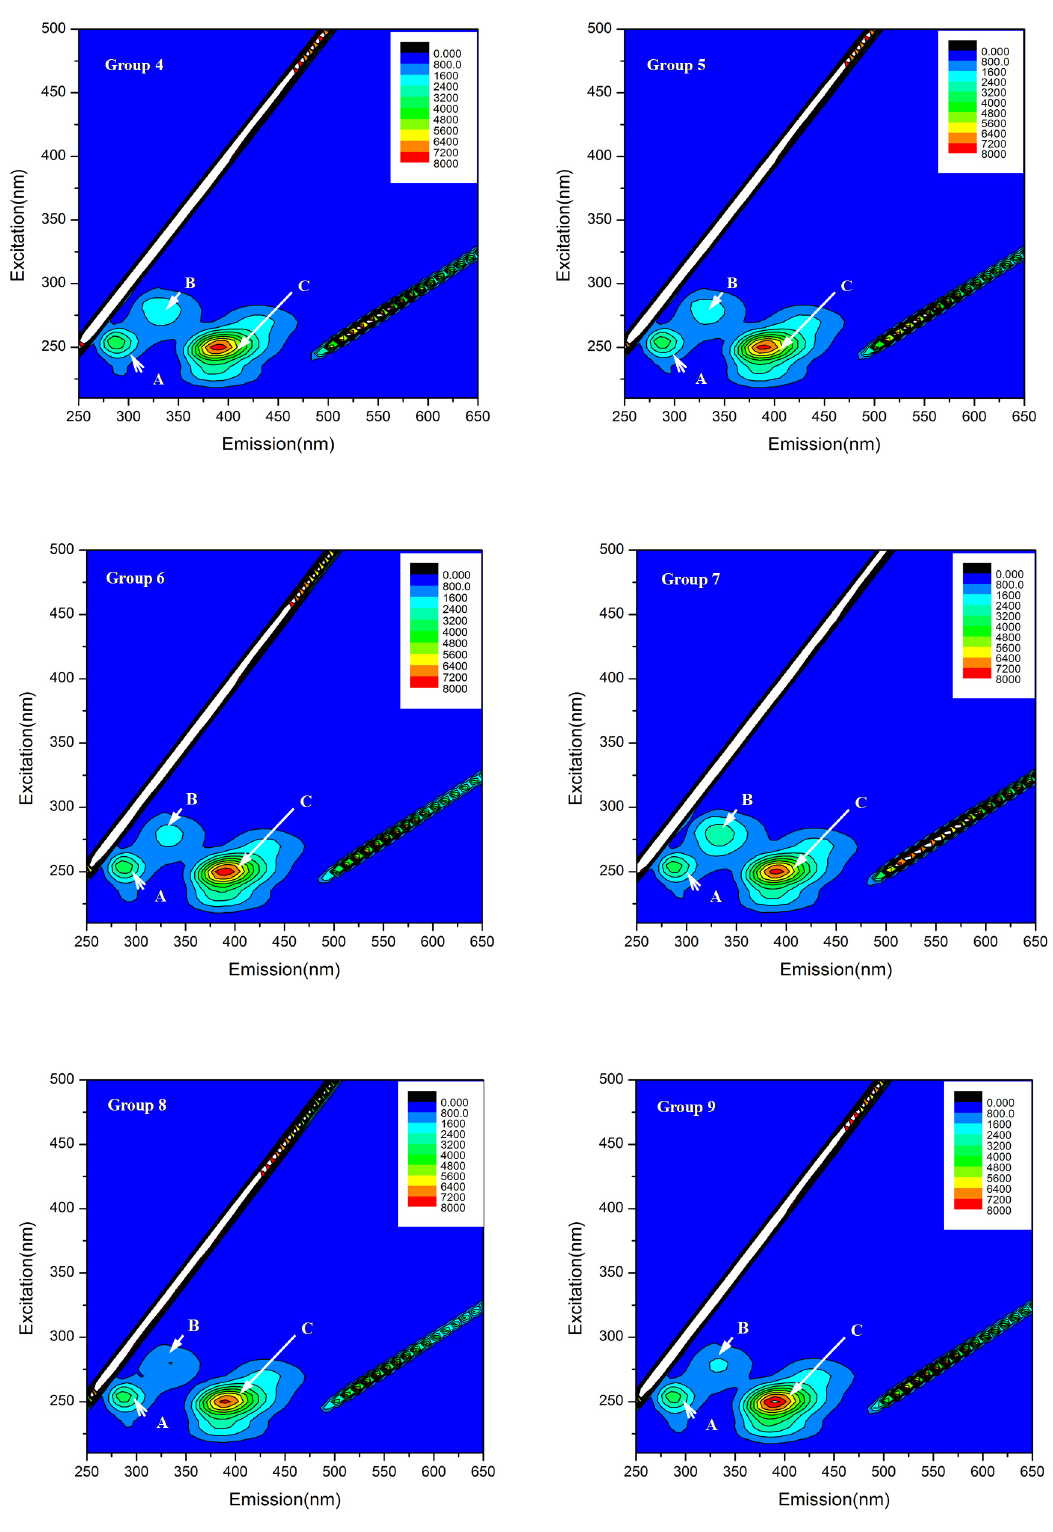
Figure 4. Typical excitation-emission matrix (EEM) contours of the various extracellular polymeric substance (EPS) fractions in control group and group 1–9. Peaks A, B, and C were obtained at Ex/Em combinations of 255/285, 280–285/315–335, and 250/390, respectively.